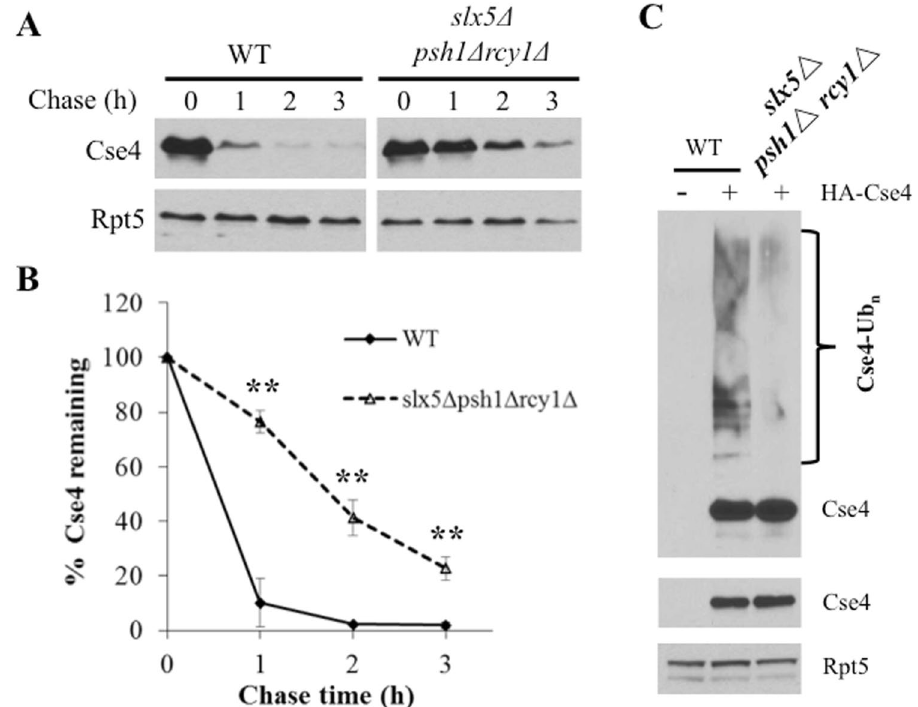
Figure 3. Cse4 ubiquitylation and degradation are impaired in the triple mutant psh1 Δ rcy1 Δ slx5 Δ cells. ( A , B ) Cse4 stability in wild-type and psh1 Δ rcy1 Δ slx5 Δ cells was determined and quantified as in Fig. 2. ( C ) Cse4 ubiquitylation is reduced in psh1 Δ rcy1 Δ slx5 Δ mutant cells. Briefly, wild-type or mutant yeast cells bearing a vector control plasmid or a plasmid expressing HA-Cse4 were grown in galactose media for 4 hours for Cse4 induction. Ubiquitylated Cse4 species were enriched by incubating extracts with tandem ubiquitin binding entities (TUBEs) agarose gel. Cse4 and its ubiquitin conjugates were detected by immunoblotting with anti-HA. Ubiquitylated and unmodified Cse4 are indicated to the right of the panel. To ensure equal loading, the amounts of Cse4 and the control protein Rpt5 in the extracts were determined and are shown in the lower